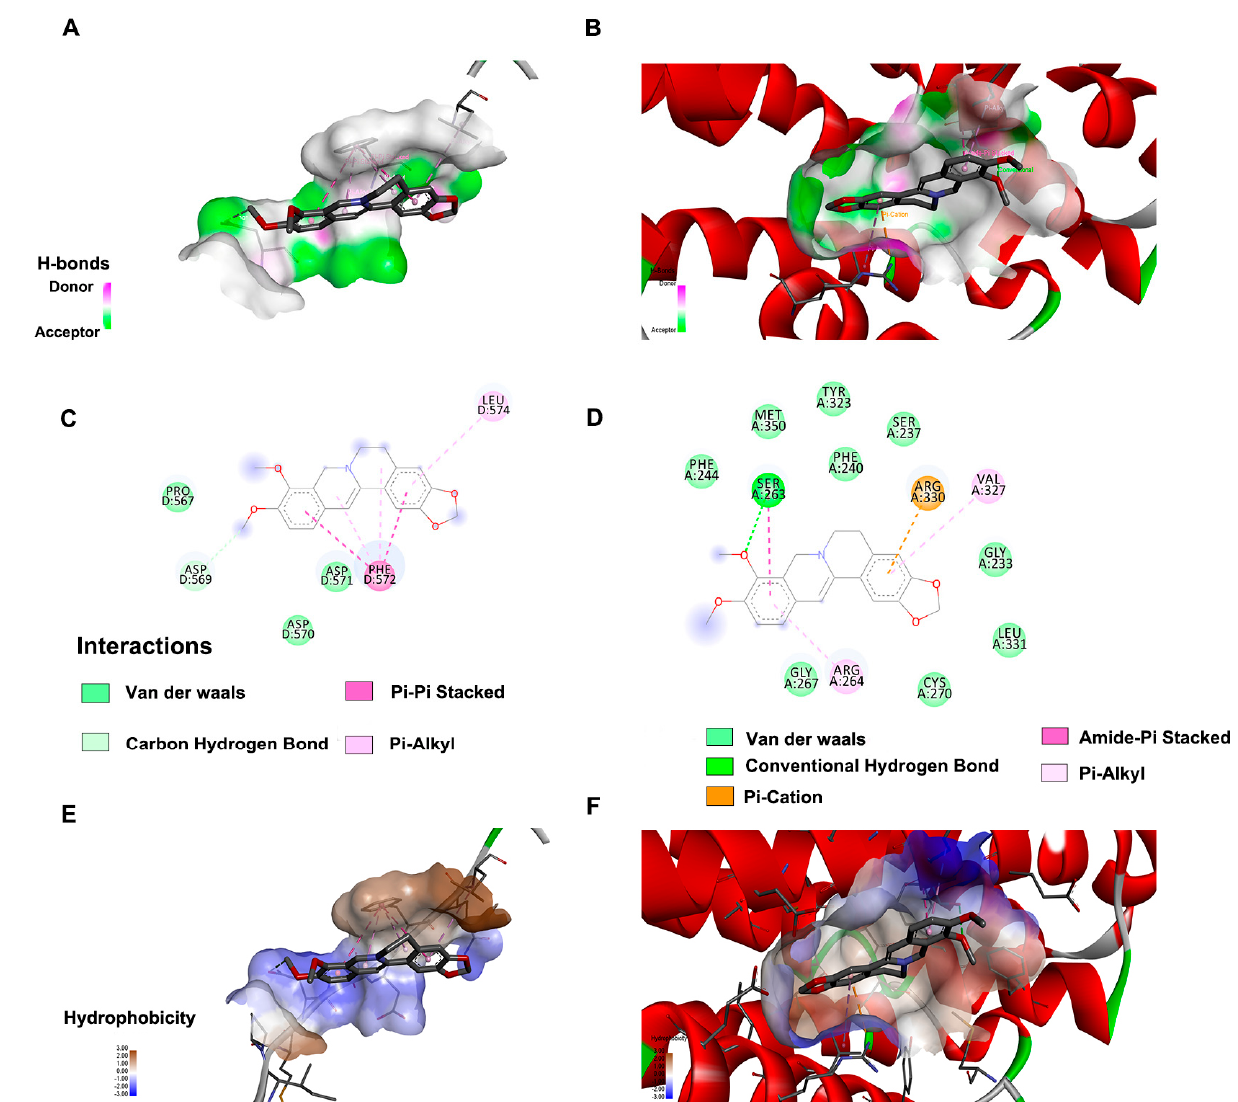
Figure 5. Molecular docking. Three-dimensional visualization of BBR docking results with HIF-1 α and RRM2 ( A , B ); 2D BBR docking results with HIF-1 α and RRM2 ( C , D ). The hydrophobic surface of HIF-1 α and RRM2 interacts with BBR; the brown and blue colors represent hydrophobicity and hydrophily, respectively ( E , F